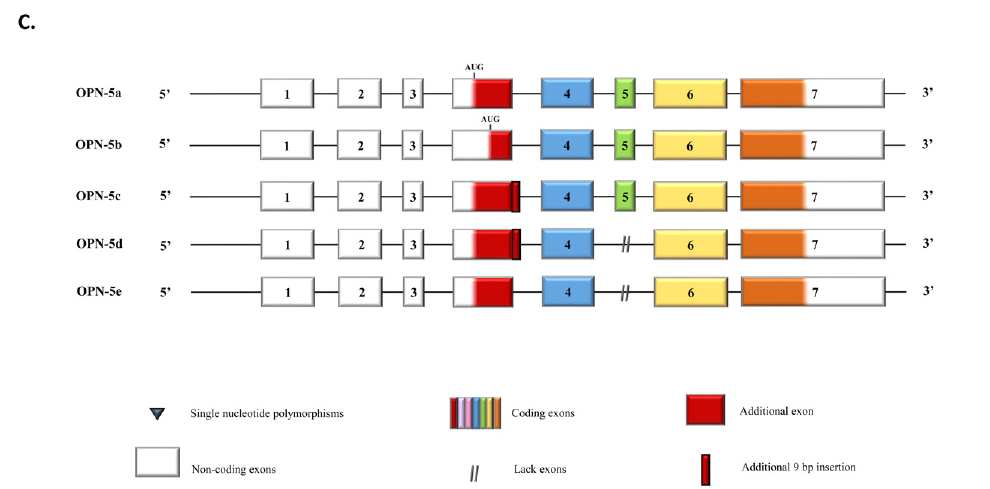
Figure 1. Schematic representation of the OPN gene and its transcripts. ( A ) OPN encoding gene located on human chromosome 4q22.1. The gene is 14,762 bp long and contains 7 exons. ( B ) OPN splice variants. The OPN primary transcript is processed by the alternative splicing resulting in at least five variants: OPN-a contains 7 exons and is known as the canonical isoform; OPN-b lacks exon 5 (green box); OPN-c lacks exon 4 (blue box); OPN-4 lacks both exon 4 and exon 5 (blue and green boxes); and OPN-5, which has an extra exon (red box), resulting from the retention of an intronic portion between exon 3 and exon 4, being the longest OPN splice variant. OPN-5 starts its translation at an alternative site located in the extra exon. ( C ) OPN-5 subvariants. OPN-5a is the OPN-5, as described above; OPN-5b has the extra truncated exon; OPN-5c has an additional 9 bp in the 3’ region in the extra exon (red box surrounded by a bolded black line); OPN-5d has an additional 9 bp in the 3’ region in the extra exon and deletion of exon 5; OPN-5e lacks exon 5. This Figure was partially based on information provided in previous reports